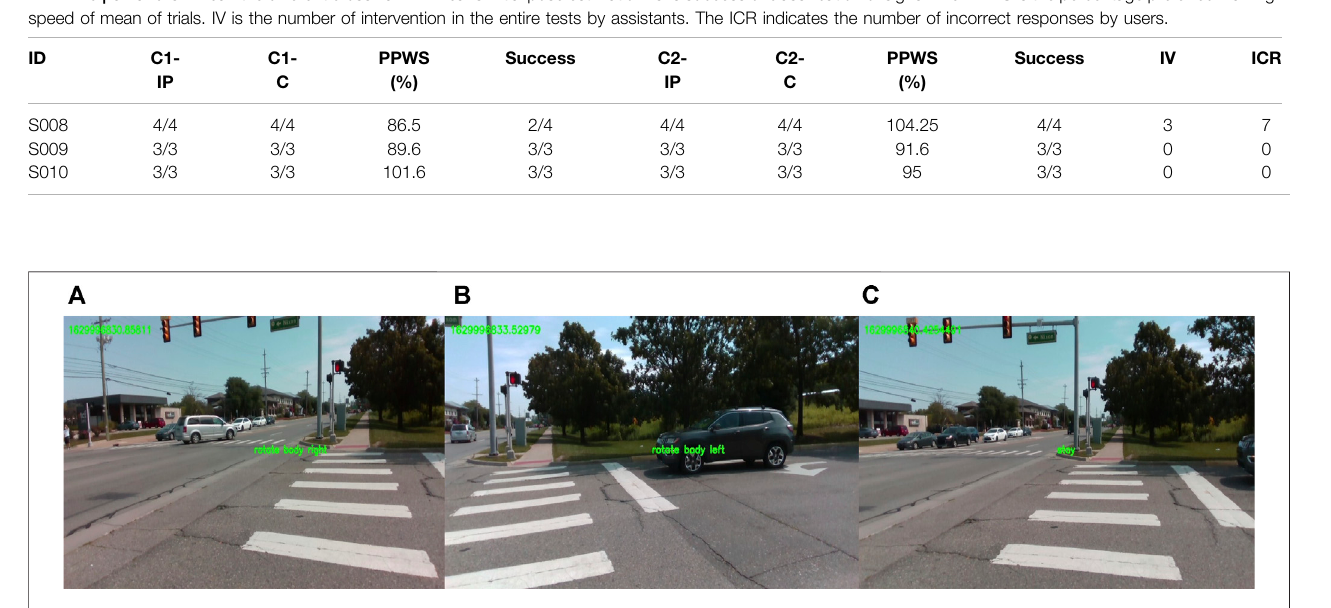
FIGURE 8 | Point of view from head mounted camera while the user waits to for the “ safe-to-cross ” signal. (A) is when the user was aligned incorrectly. (B) is the result of reaction from “ rotate body left. ” (C) is when they were properly aligned.